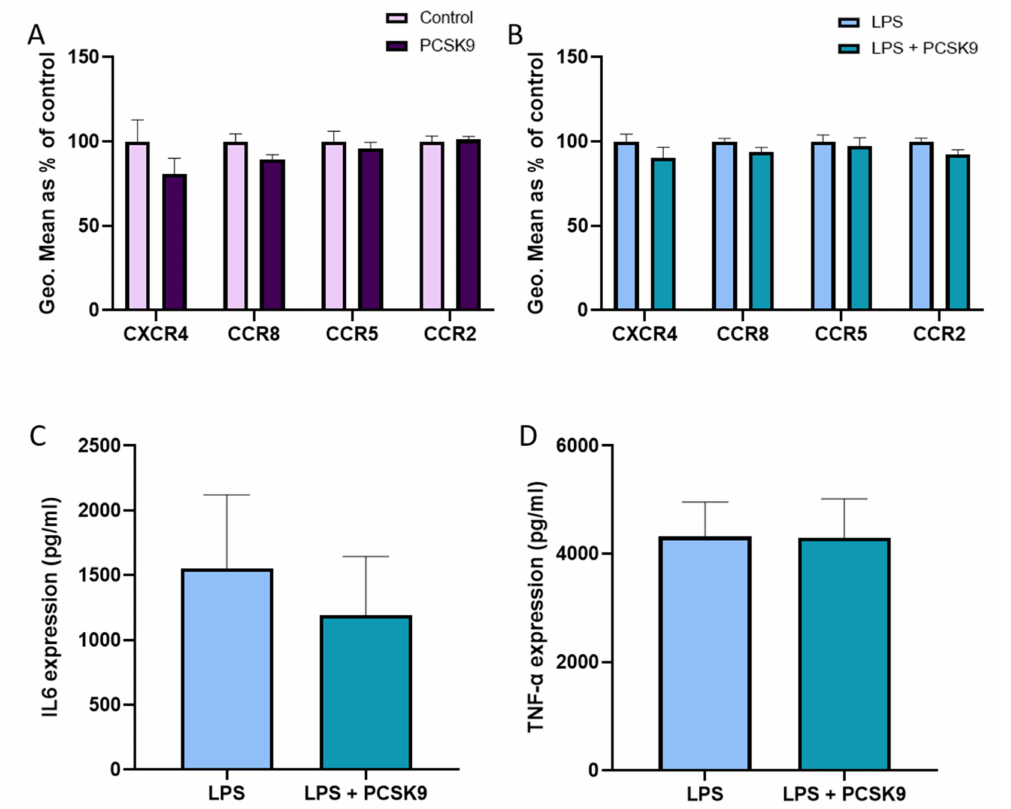
Figure 6. PCSK9 does not change the expression of chemokine receptors and inflammatory cytokines in human macrophages in vitro. Peripheral blood mononuclear cells (PBMCs) isolated from buffy coats were incubated with monocyte-specific antibodies to isolate human monocytes. These monocytes were then cultured with macrophage colony stimulating factor (M-CSF) for seven days, allowing them to differentiate into macrophages. The expression of chemokine re- ceptors CXCR4, CCR8, CCR5, and CCR2 measured using flow cytometry and represented using geometric mean (Geo.Mean) in human macrophages ( n = 3–4 replicates) with and without PCSK9 ( A ) and when exposed to inflammatory stimulus with LPS ( B ). Inflammatory cytokines IL6 ( C ) and TNF- α ( D ) expression measured in the supernatant of the cell culture with and without PCSK9 in an inflammatory environment ( n = 3–4 replicates). Bar graphs are representation of mean ± SEM. 2-way ANOVA was used for ( A , B ), and Mann–Whitney test was used for ( C , D ) to calculate the statistical